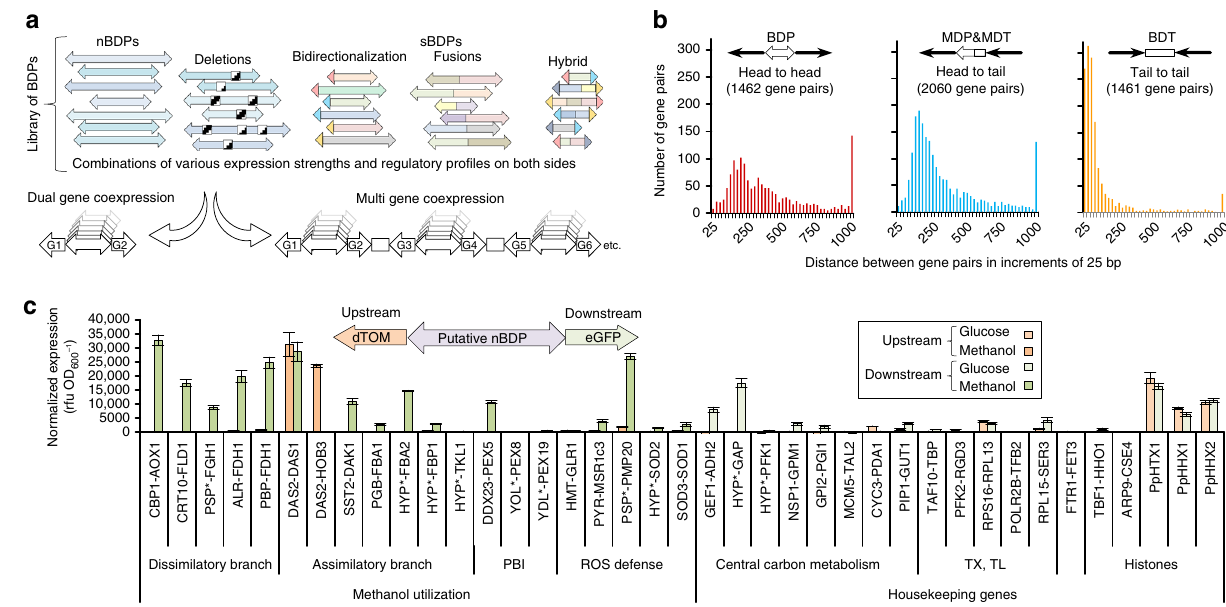
Fig. 1 A library of bidirectional promoters (BDPs) for gene co-expression fi ne-tuning and bidirectional histone promoters are among the few strong P. pastoris nBDPs. a A library of diversely regulated natural and synthetic BDPs (nBDPs and sBDPs) covering a wide range of regulatory pro fi les facilitates optimization of dual gene co-expression and the assembly of multi-gene co-expression cassettes (Supplementary Fig. 5, Supplementary Note 6). b The P. pastoris genome harbors 1462 putative nBDPs (gene pairs in divergent head-to-head orientation, Supplementary Data 1, Supplementary Note 1). The distribution of distances between gene pairs is shown in 25 bp intervals. The last bar indicates gene pairs with an intragenic distance >1000 bp.